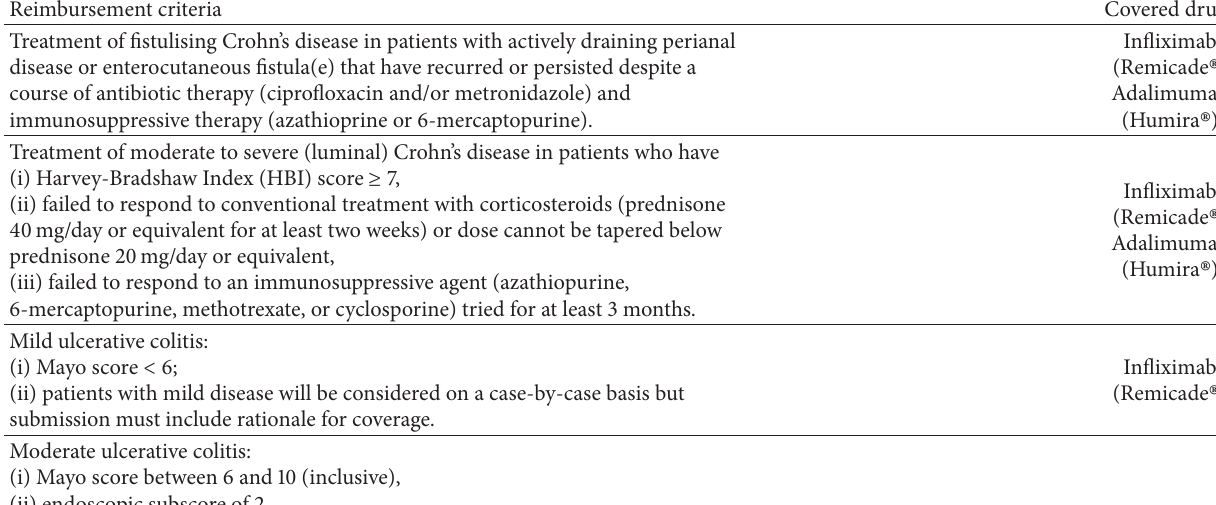
Table1:Exceptionalaccessprogram(EAP)reimbursementcriteriaforinitialapprovalforuseinCrohn’sdiseaseandulcerativecolitispatients. These criteria did not change during the study